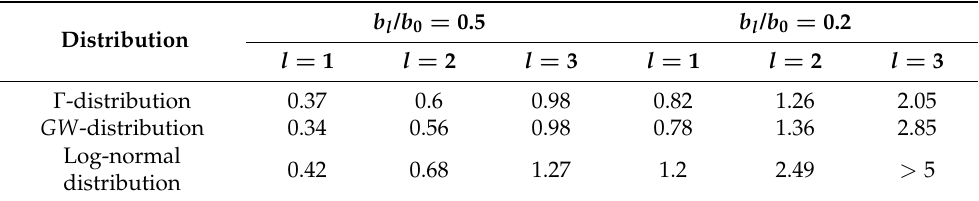
Table 3. Boundary values for the coefficient of variation c ∗ for ( 3 + 1,5 ) -out-of-6 : F system.